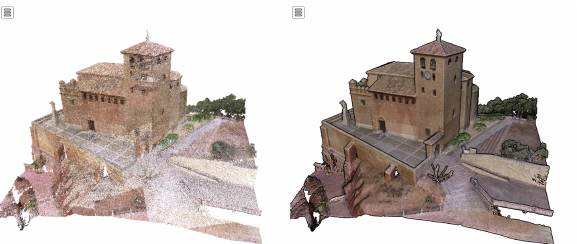
Figure 11. WebGL environment: point cloud visualization of the Santa Tecla church (Cervera de la Ca˜nada, Spain) with different rendering features.